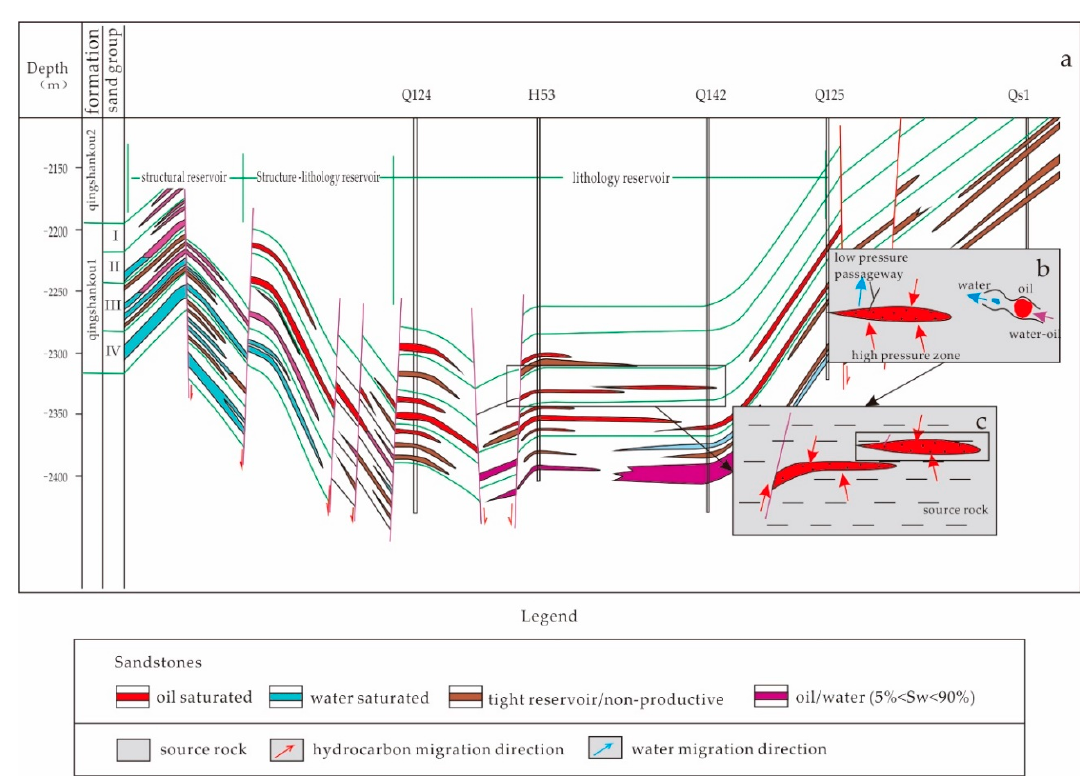
Figure 9. Reservoirs distribution and the accumulation characteristics of delta front sand bodies. ( a ) Reservoir Types and reservoir sector in Daqingzijing Oilfield; ( b ) Diagram of the Mechanism of filter-style accumulation; ( c ) Sketch of hydrocarbon migration direction.